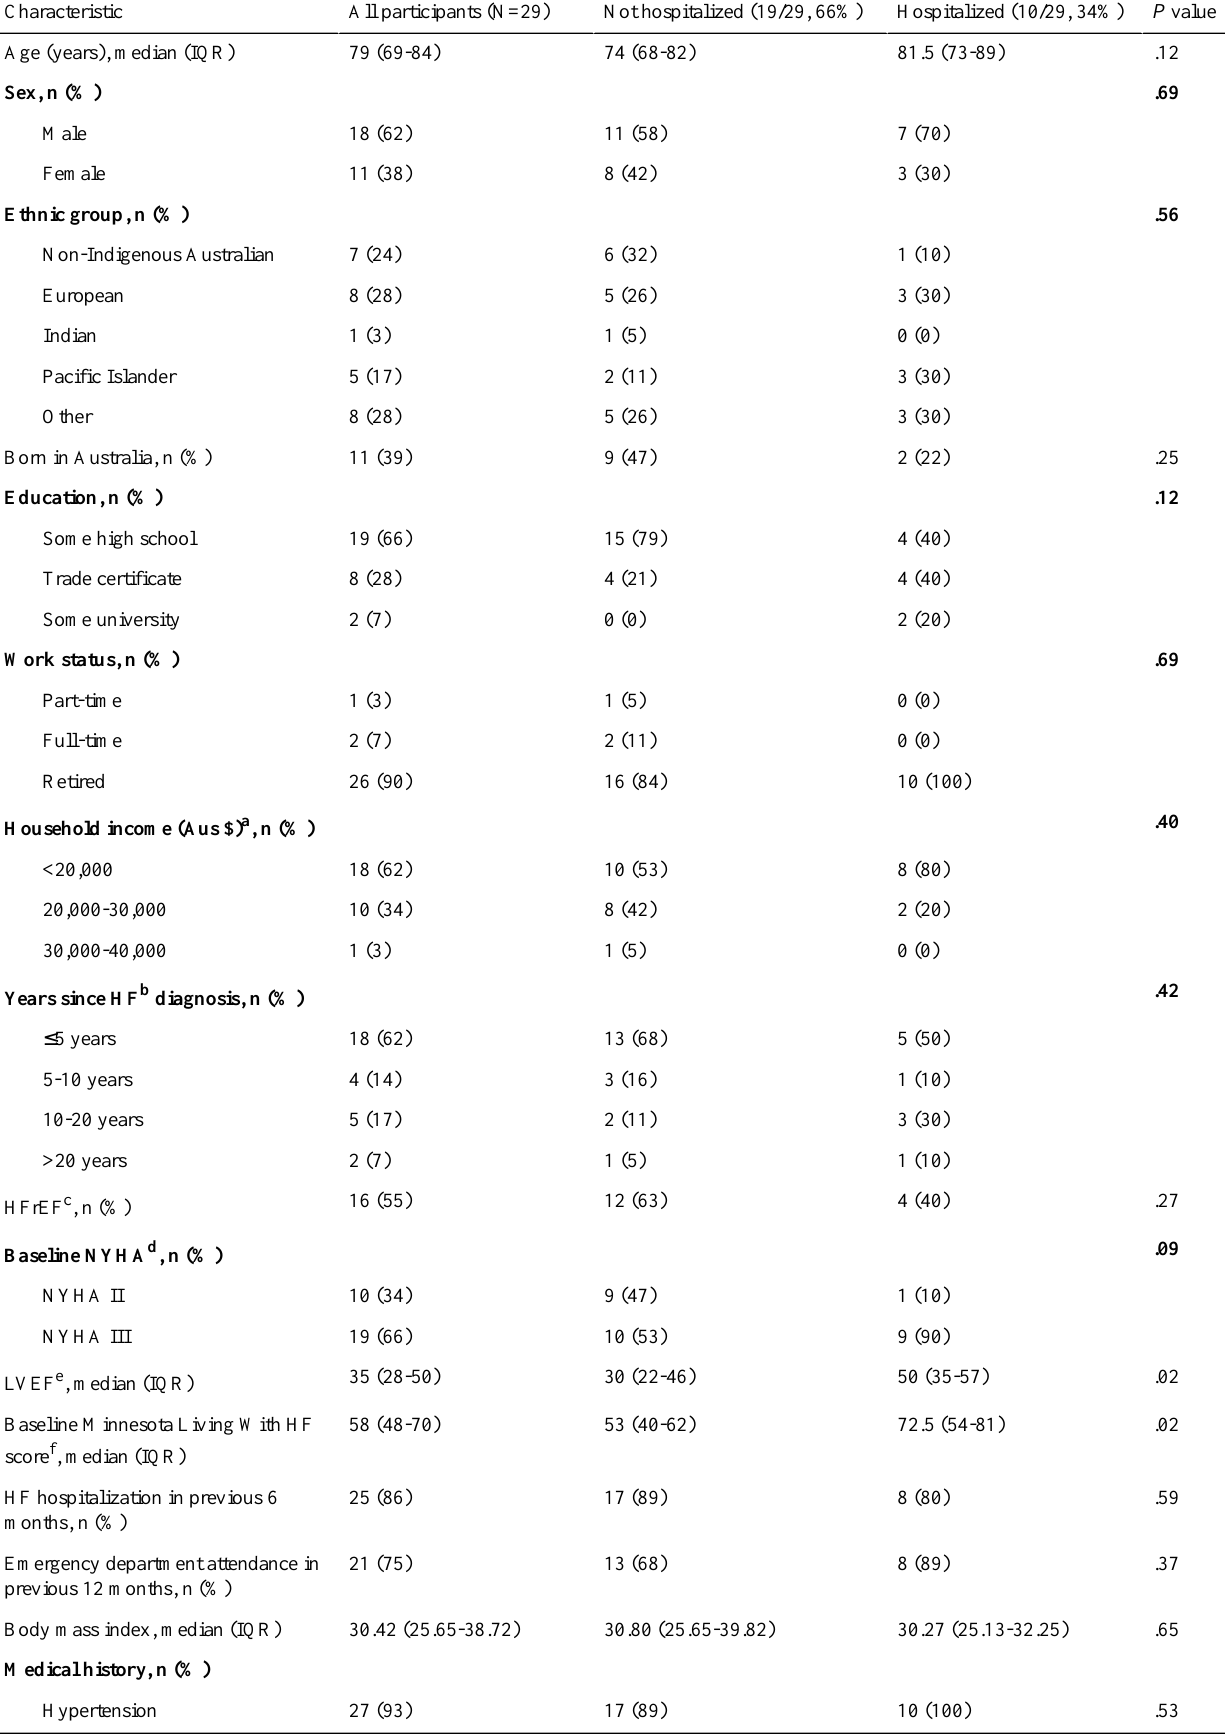
Table 2. Baseline demographics and comparison by heart failure